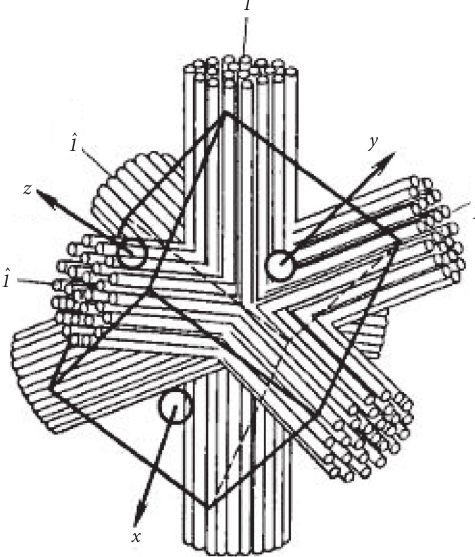
Figure 1: Four-directional reinforcement scheme and coordinate system location; x , y , z are the principal axes of elastic symmetry; ˆı is the direction of the reinforcement